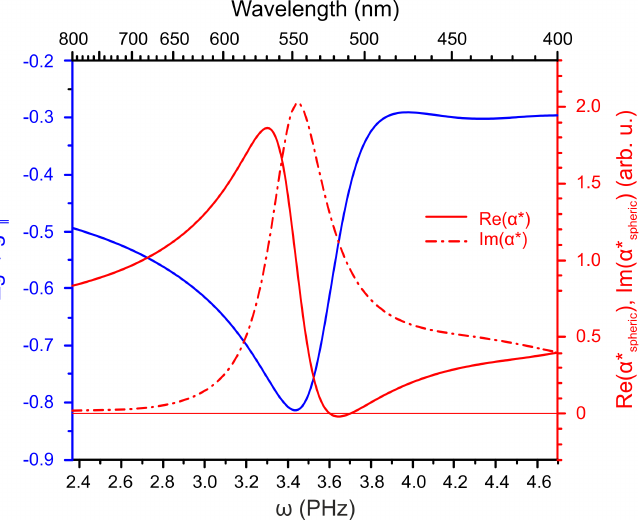
Figure 5. Frequency dependence of the reduced anisotropy of the effective gyration tensor and of the effective polarizability of the gold NPs in the nematic host